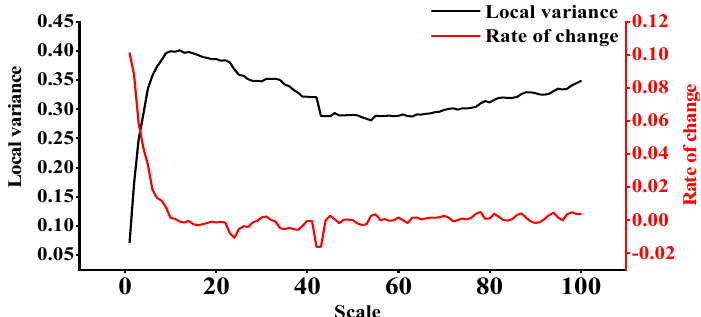
Figure 13. Segmentation scale for algorithm for estimating scale parameters.